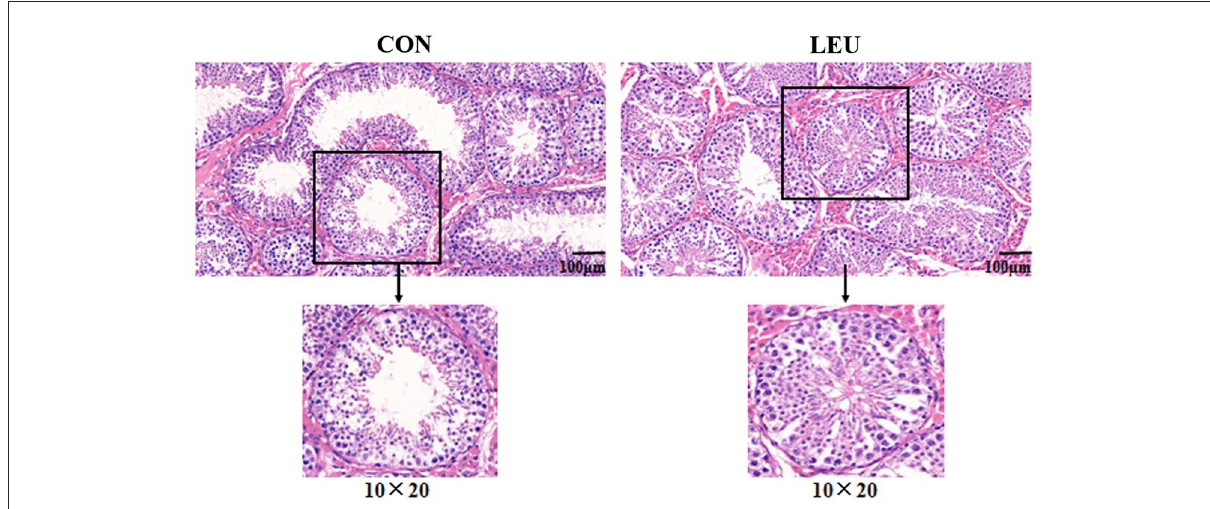
FIGURE2 HE staining of 150-days-old testicular tissue in CON and LEU. CON, control group; LEU, leucine group. All the pictures are magnified 200 times.